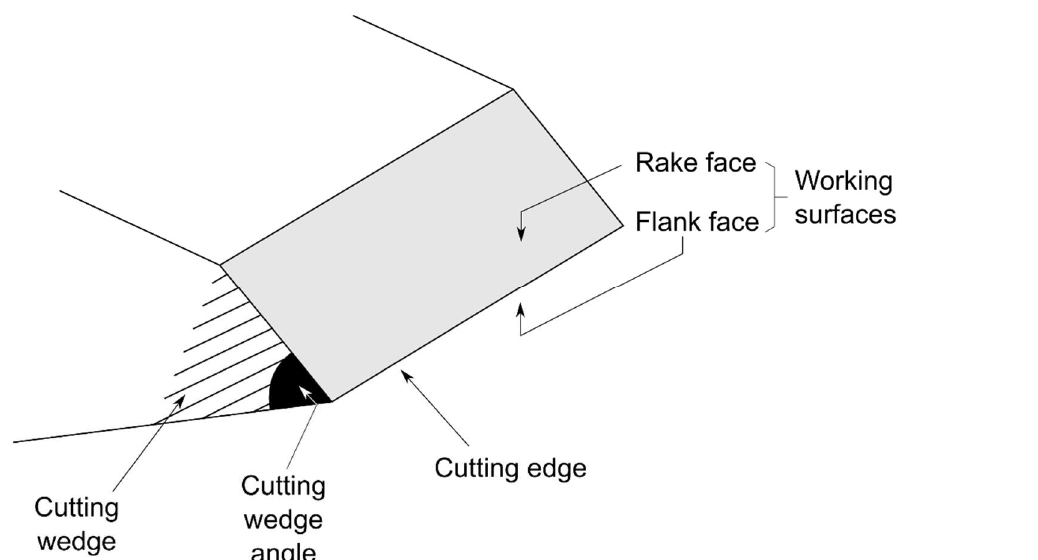
Figure 13. Terms used to describe the geometry of a tool transformative unit (modified from Soriano et al.